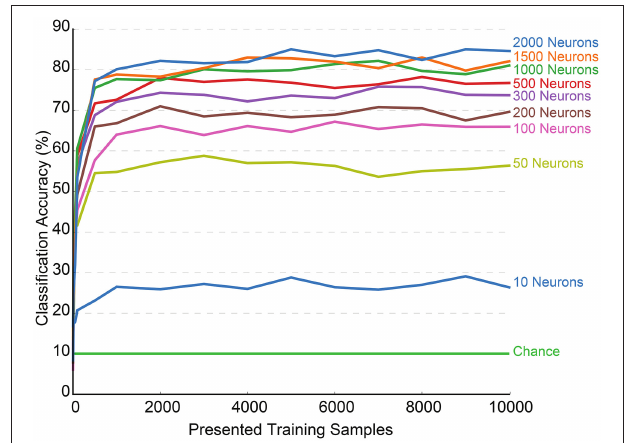
FIGURE 4 | Training accuracy over the first 10,000 presented samples for N-MNIST using SKIM for increasing numbers of hidden layer neurons. Each configuration of hidden layer neurons was trained sequentially through a randomly shuffled training sequence, and tested against the testing dataset at increments of 1000 hidden layer neurons. Each test was performed independently of the training, and no learning took place during the testing phase. Also shown on the graph are the accuracies due to chance, which is 10% for the 10-class classification task. The final results shown on the right represent the full training accuracy tested against the full 10,000 training samples whilst intermediate points on the curve were calculated over a randomly drawn subset of 2000 testing samples.